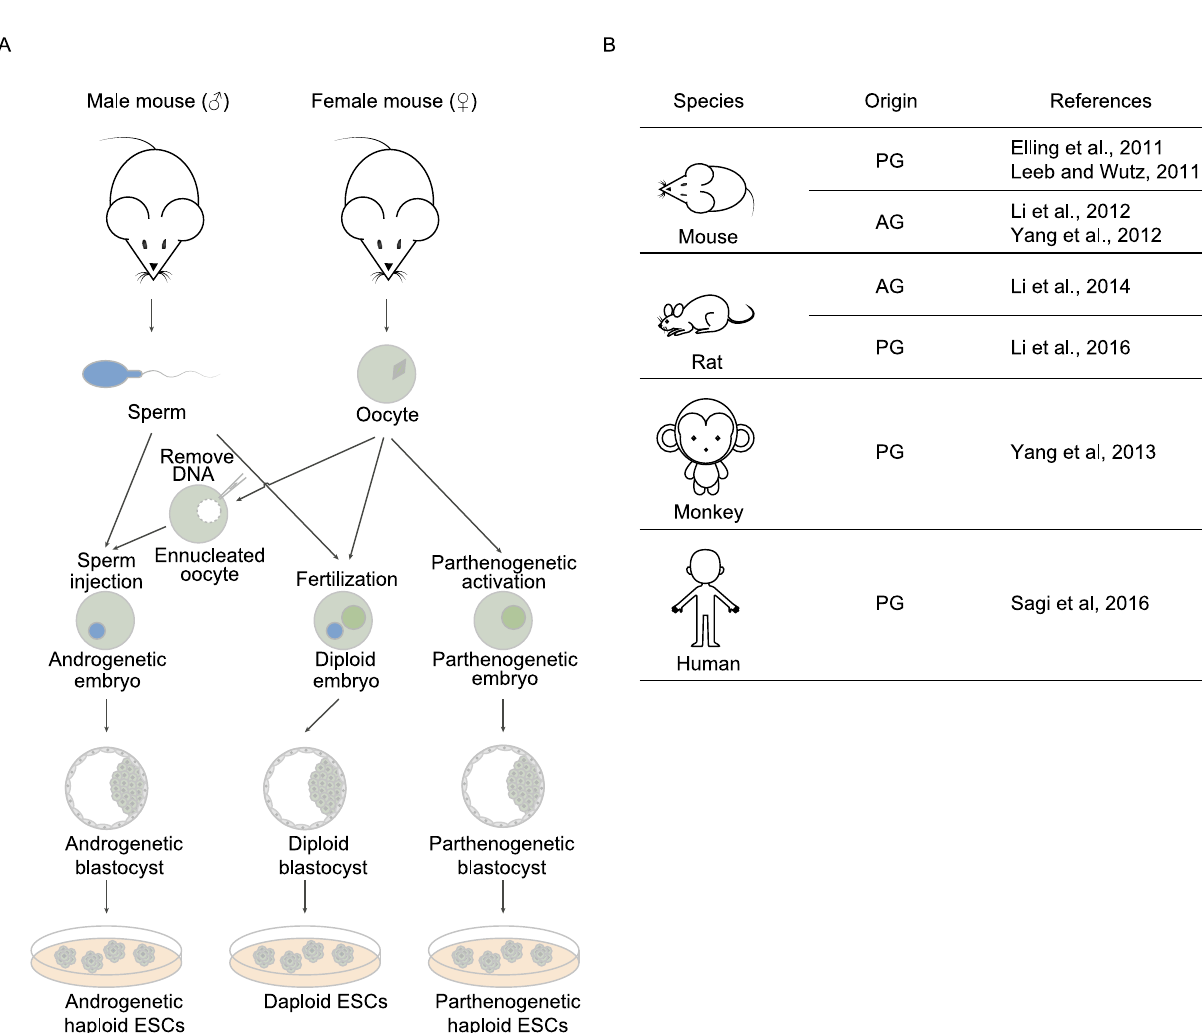
Figure 1. Derivation of mouse haploid embryonic stem cells (haESCs). (A) Derivation strategies of parthenogenetic haESCs (phESCs) and androgenetic haESCs (ahESCs). Parthenogenetic haploid blastocysts are developed from arti fi cially activated MII oocytes. Androgenetic embryos can be obtained by injecting sperm into the enucleated MII oocytes or removing the female pronucleus from fertilized oocytes. The resulting haploid blastocysts are subsequently cultured to develop haESC lines. (B) The haESC lines of different mammalian species have been